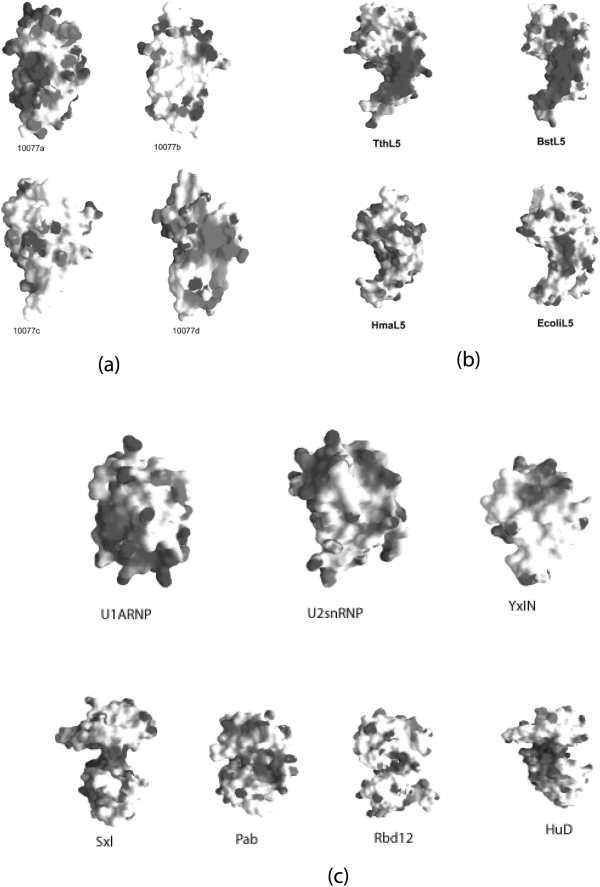
Electrostatic potential surfaces of a) UPF0201 proteins and selected b) L5 (PDB Code: 1IQ4 (BstL5), 1MJI (TtL5), 1JJ2 (HmaL5) and 2AWB (EcolL5) and c) non-L5 (PDB Code: 1OIA (U1ARNP), 2G0C (YxIN)) RRM homologs.Color-coding denotes calculated electrostatic potential (red: <−10 kT; blue: >+10 kT) and underlying residue conservation as acidic (red) and basic regions (blue).